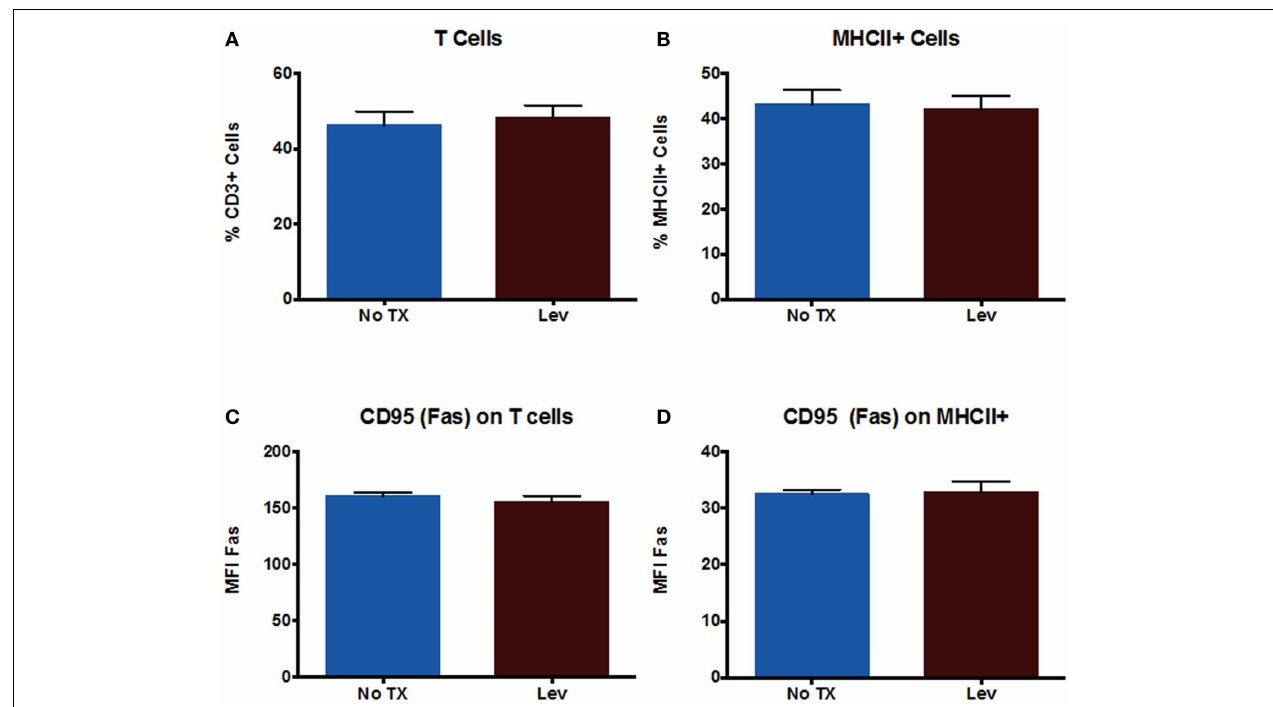
measure of relative expression level of CD95 on (C) T cells and (D) MHCII + cells in splenocytes 48h after treatment with or without 0.15mM Lev. *Denotes a p -value < 0.05.